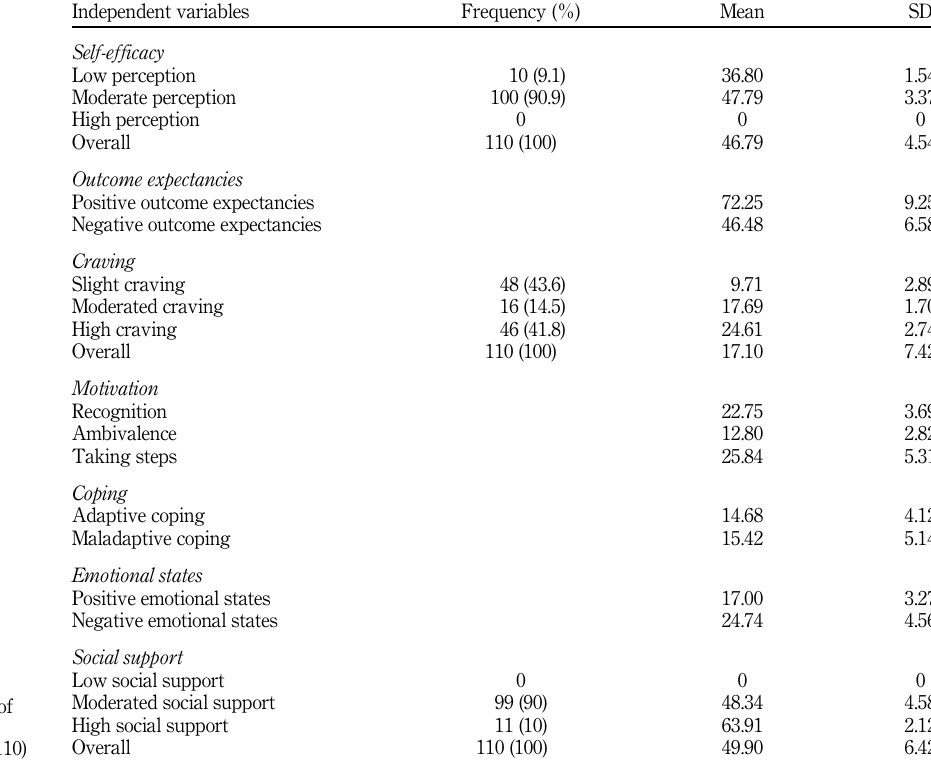
Table IV. Characteristics of independent variables ( n 5